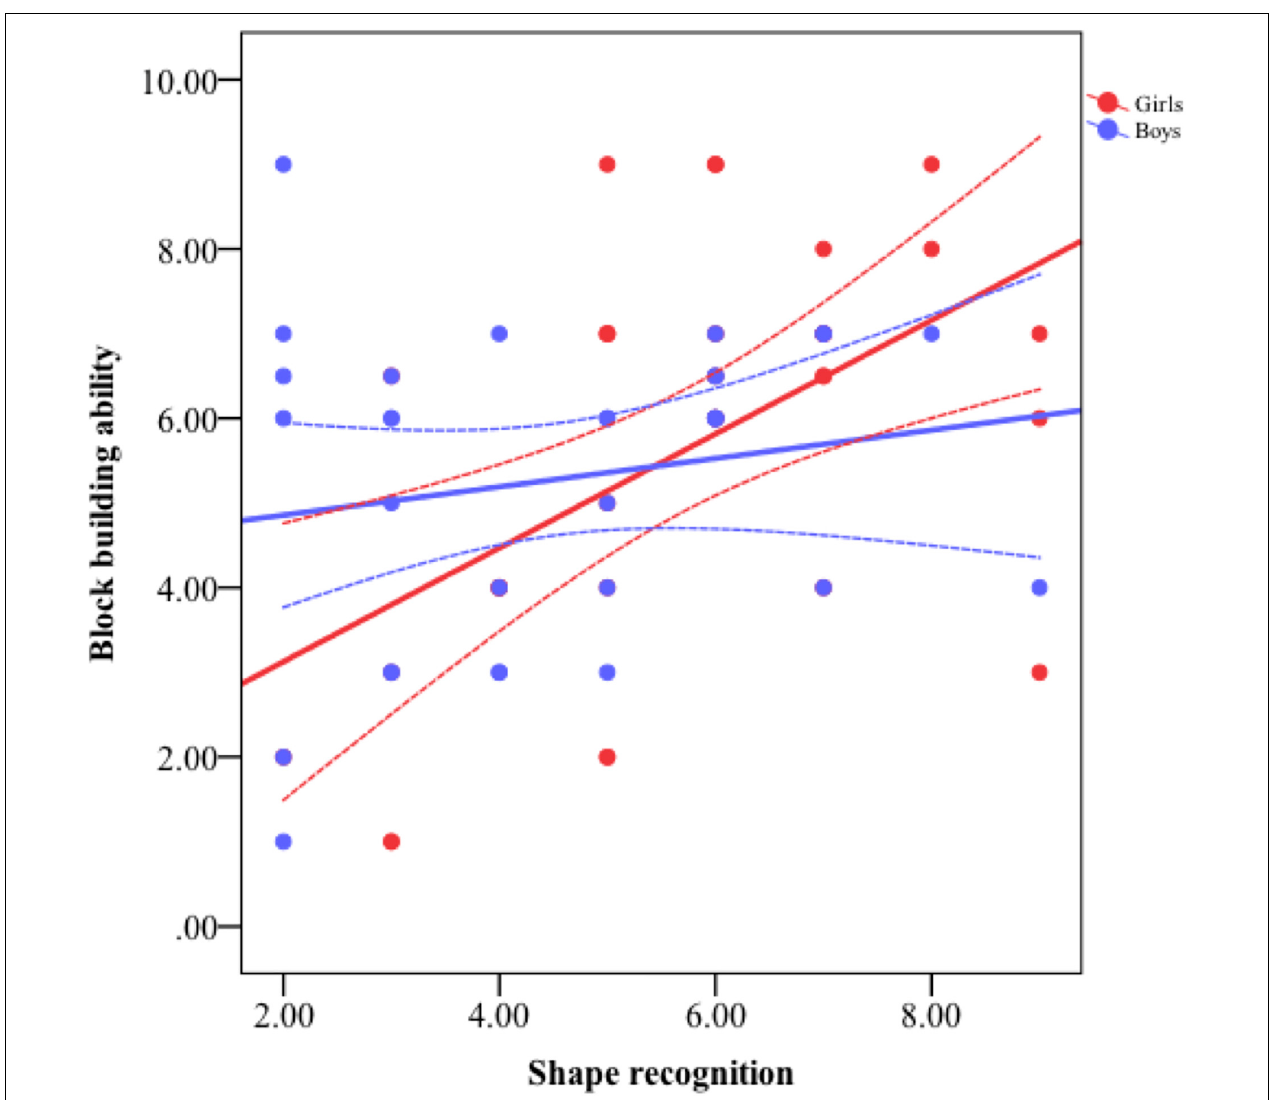
FIGURE 6 | The association between shape recognition and block building ability by